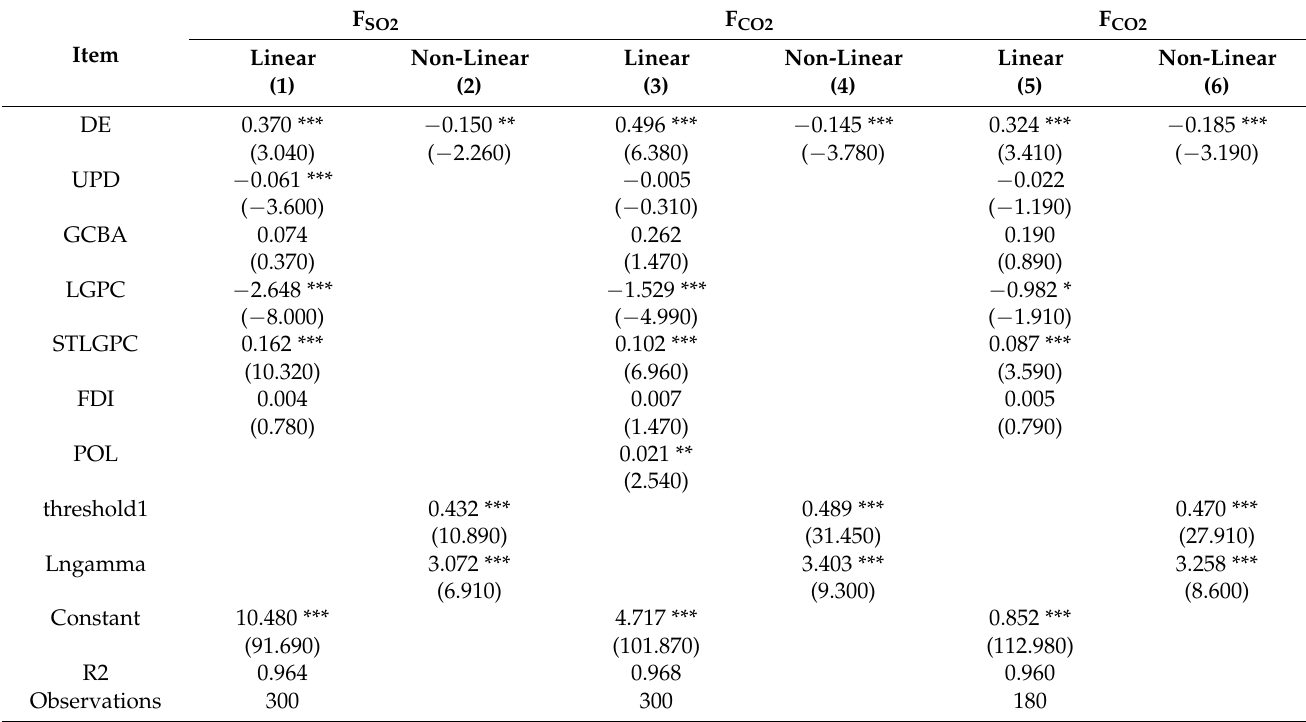
Table 7. Robustness